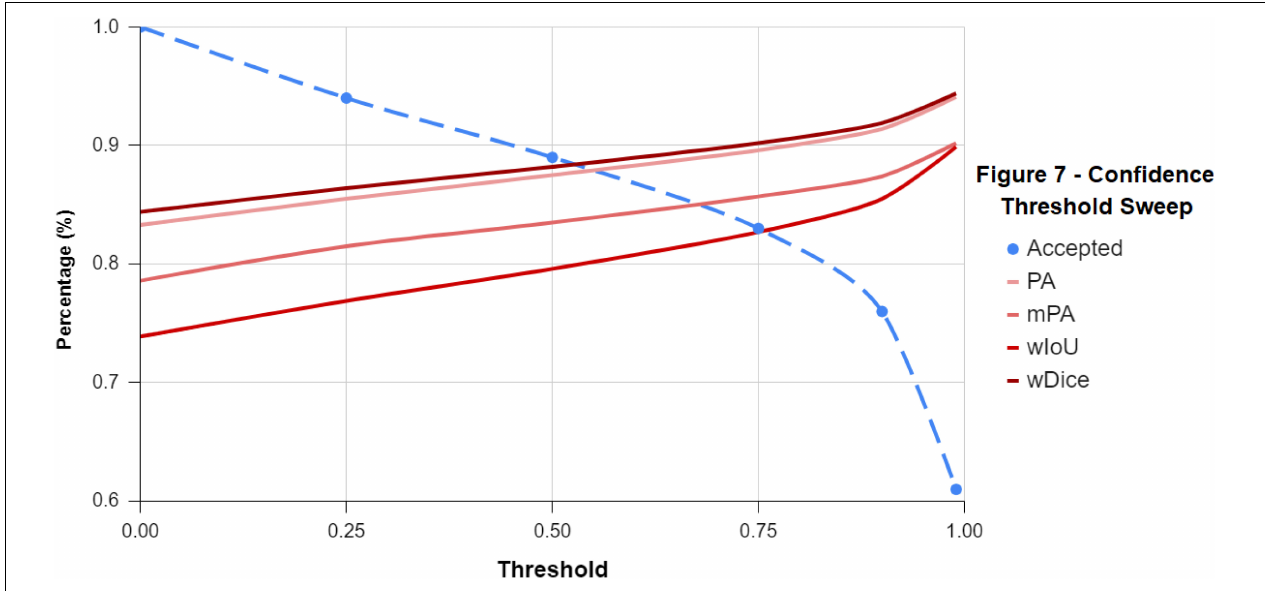
FIGURE 7 | A line-graph displaying the inverse relationship between the confidence threshold value and the classification scores of the sparse labels accepted. As the threshold value increases and becomes more conservative along the x -axis, more of the sparse labels the classifier was unsure about were rejected.